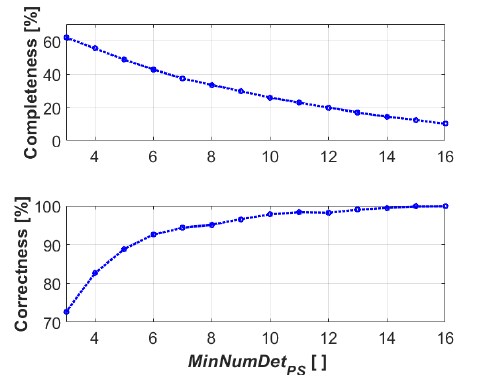
Figure 3: Completeness and correctness as a function of 𝑀𝑖𝑛𝑁𝑢𝑚𝐷𝑒𝑡 𝑃𝑆 for the total area of all 18